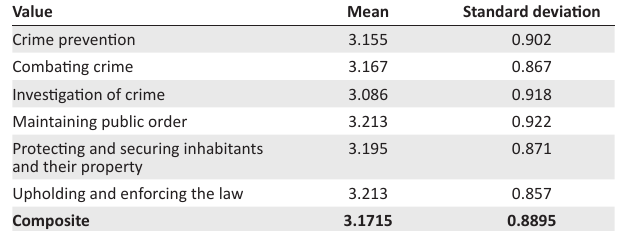
TABLE 4: Summary statistics of value. Value Mean Standard deviation Crime prevention